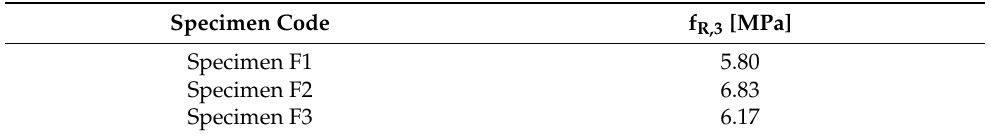
Table 5. Flexural tensile strength results at 28